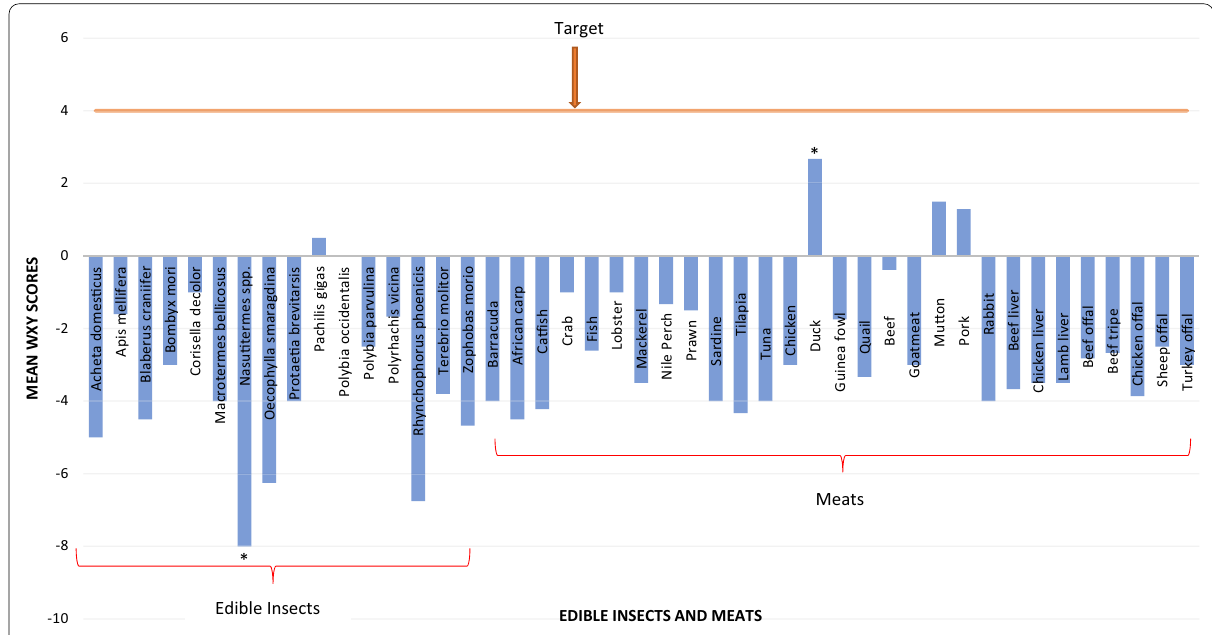
Fig. 1 Bar graph showing mean WXY scores for meats and edible insects. * Nasutitermes spp. was significantly more healthful than duck ( P <